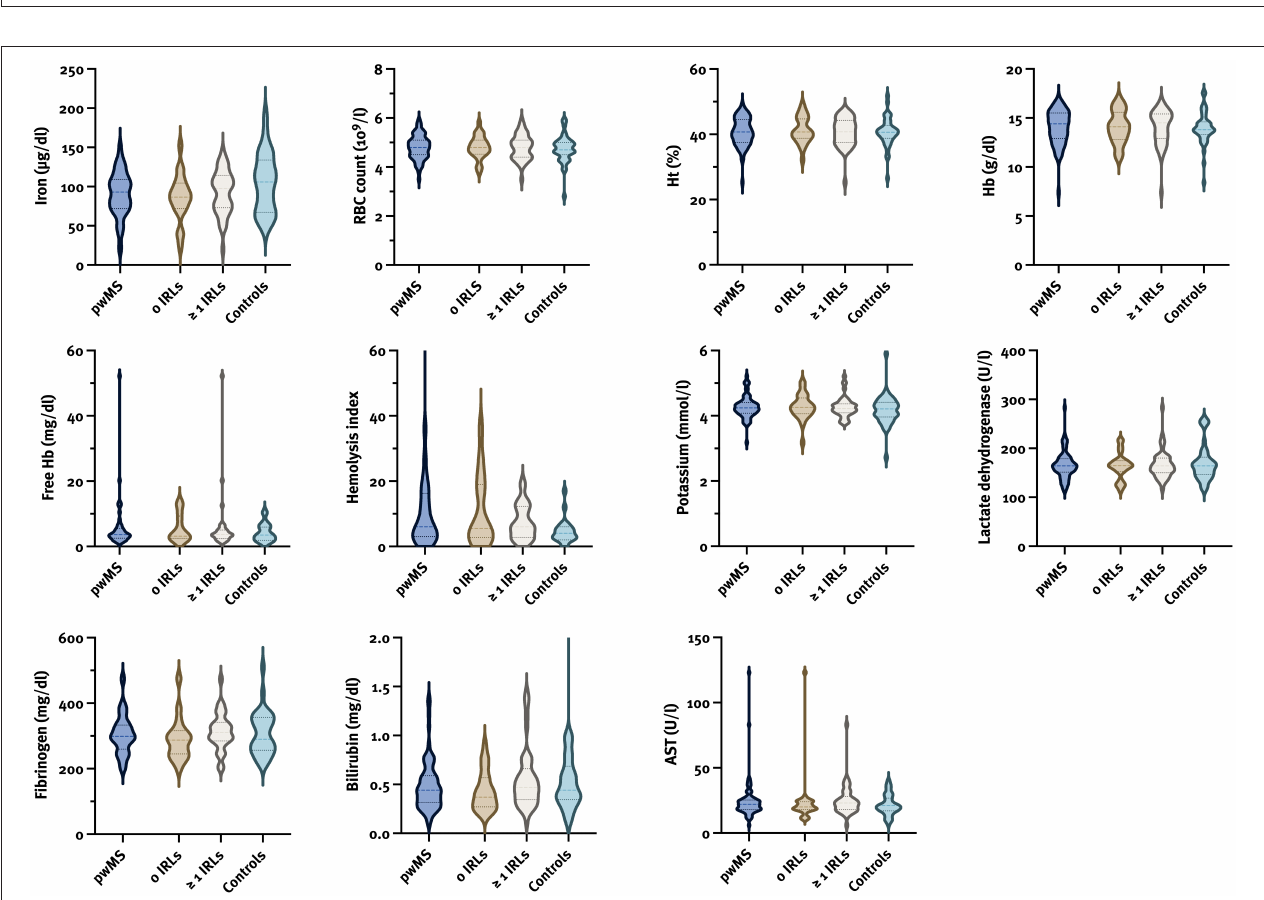
FIGURE 2 | Violin plots for hemolysis parameters in pwMS according to the presence of IRLs and controls. AST, aspartate transaminase; Hb, hemoglobin; Ht, hematocrit; IRL, iron rim lesion; pwMS, patients with multiple sclerosis; RBC, red blood cell.